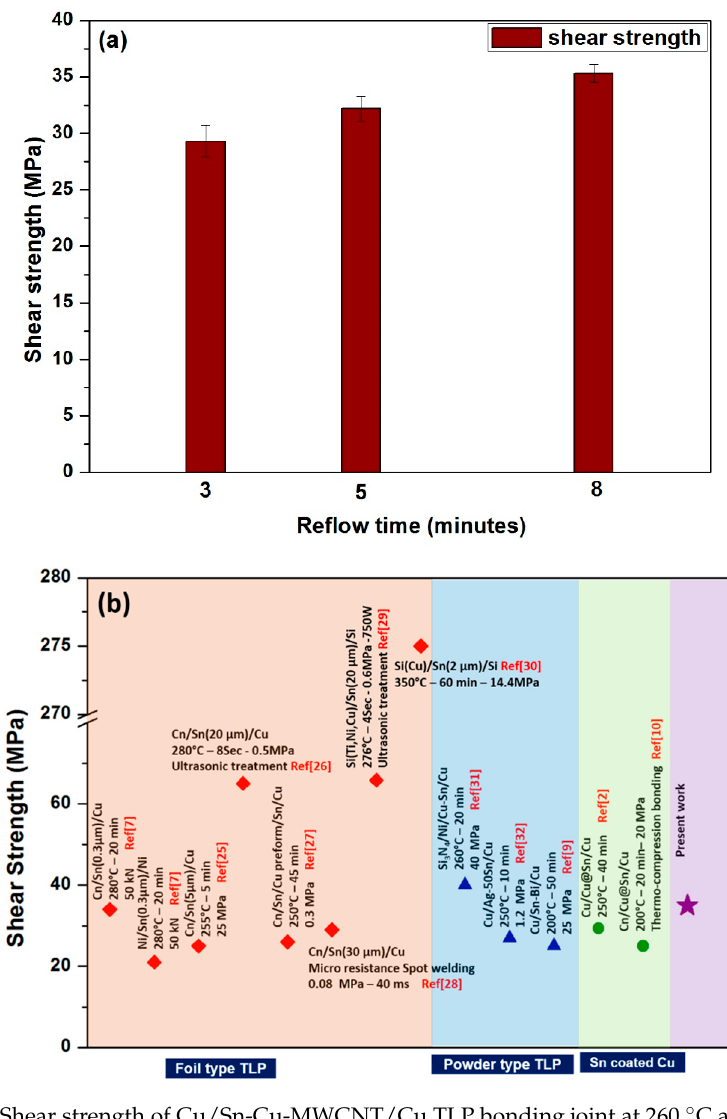
Figure 5. ( a ) Shear strength of Cu/Sn-Cu-MWCNT/Cu TLP bonding joint at 260 ◦ C as a function of reflow time; ( b ) Comparison of the shear strength data in the present work with the literature.